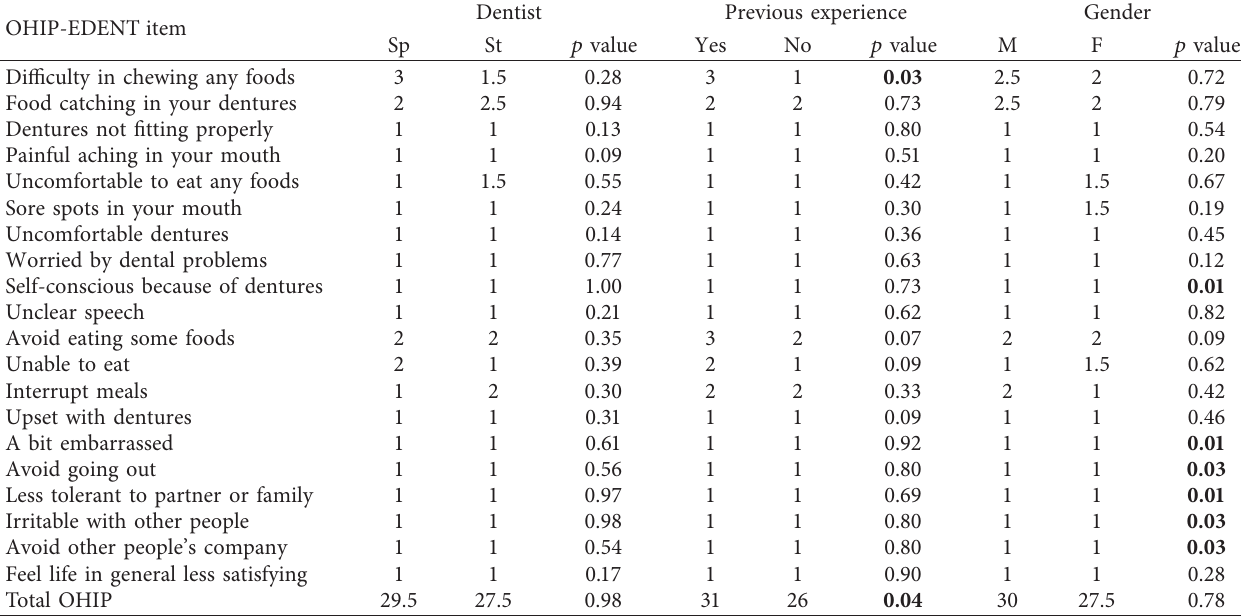
Table 4: Results of the median and statistical analysis for the different questions included in the OHIP-EDENTpart of the questionnaire for the factors dentist, previous experience, and